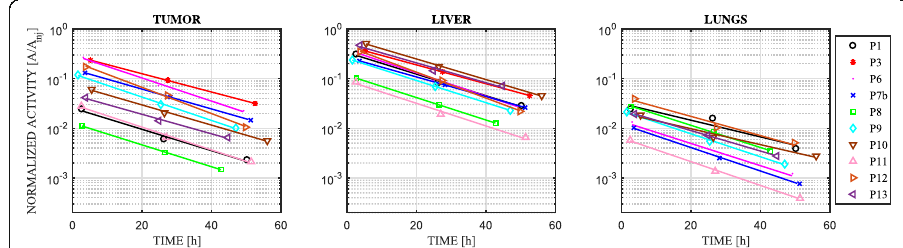
Fig. 3 Normalized time-activity curves of tumor, liver and lungs for patients that were scanned three times after 188 Re-HDD-Lipiodol